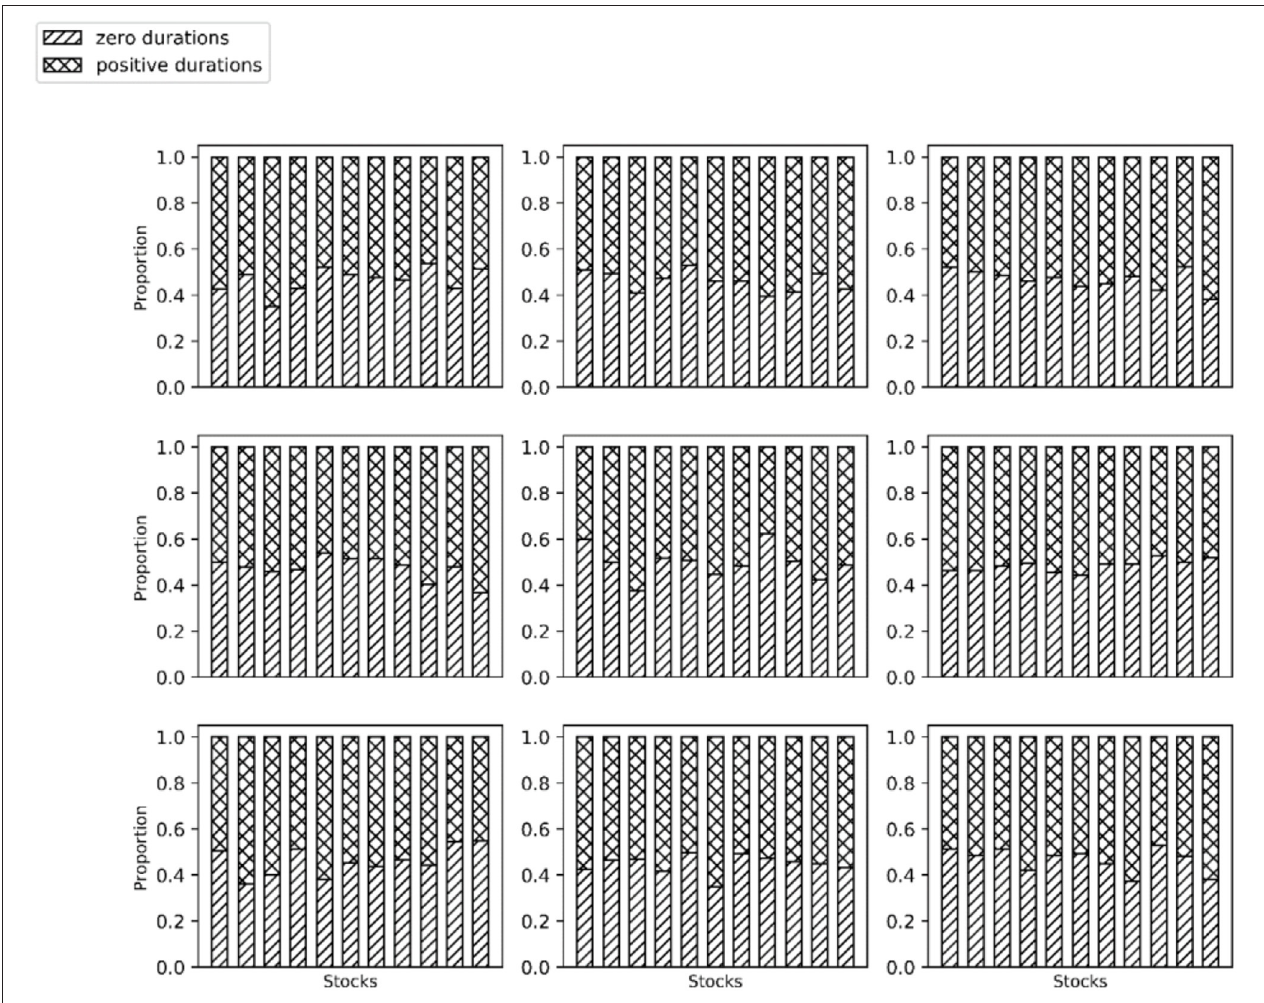
FIGURE 2 | The proportion of zero duration and positive duration.